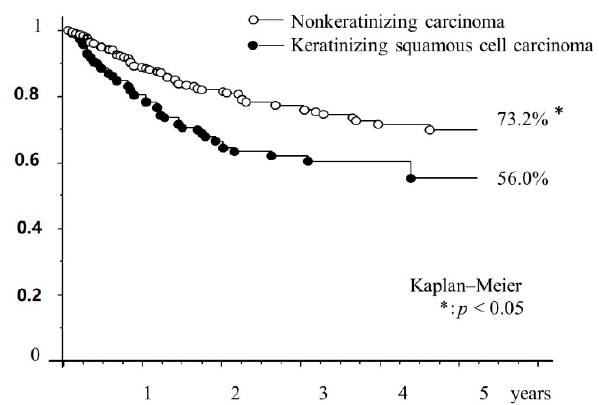
Figure 7. Kaplan–Meier curve for overall survival according to pathology. Asterisks indicate significant difference compared with the pathology ( p < 0.05).